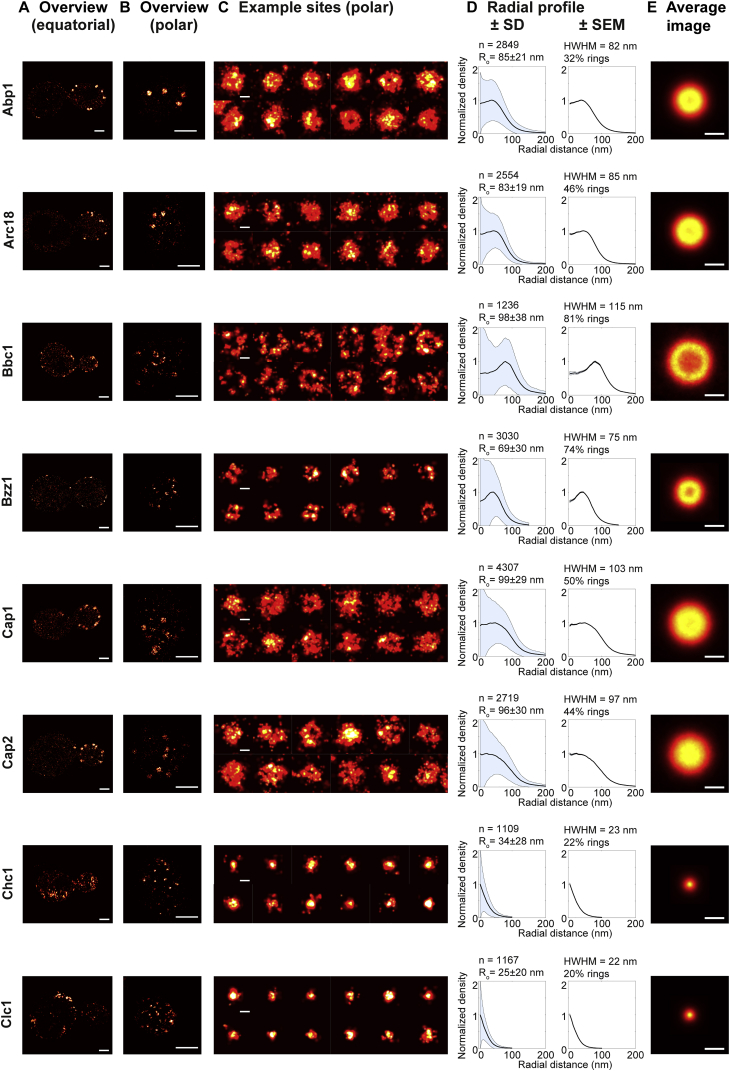
Overview of Imaged Endocytic Proteins (Part 1/3), Related to Figures 1 and 2(A and B) Shown are superresolved images of cells where the focal plane was positioned on the midplane (A) and bottom (B) of the cells.(C) Shows example endocytic sites focused as in (B).(D) Shows average radial profiles. Shaded areas correspond to the standard deviation (left) or standard error of the mean (right).(E) Shows the average image. The number of sites, fraction of rings as obtained by the fit from the dr/rout values (see the STAR Methods for details), the half-maximum of radial profiles (HWHM), as well as the mean and standard deviation of the outer radius as obtained by the fit are indicated. Scale bars 1 μm (A and B) or 100 nm (C and E).